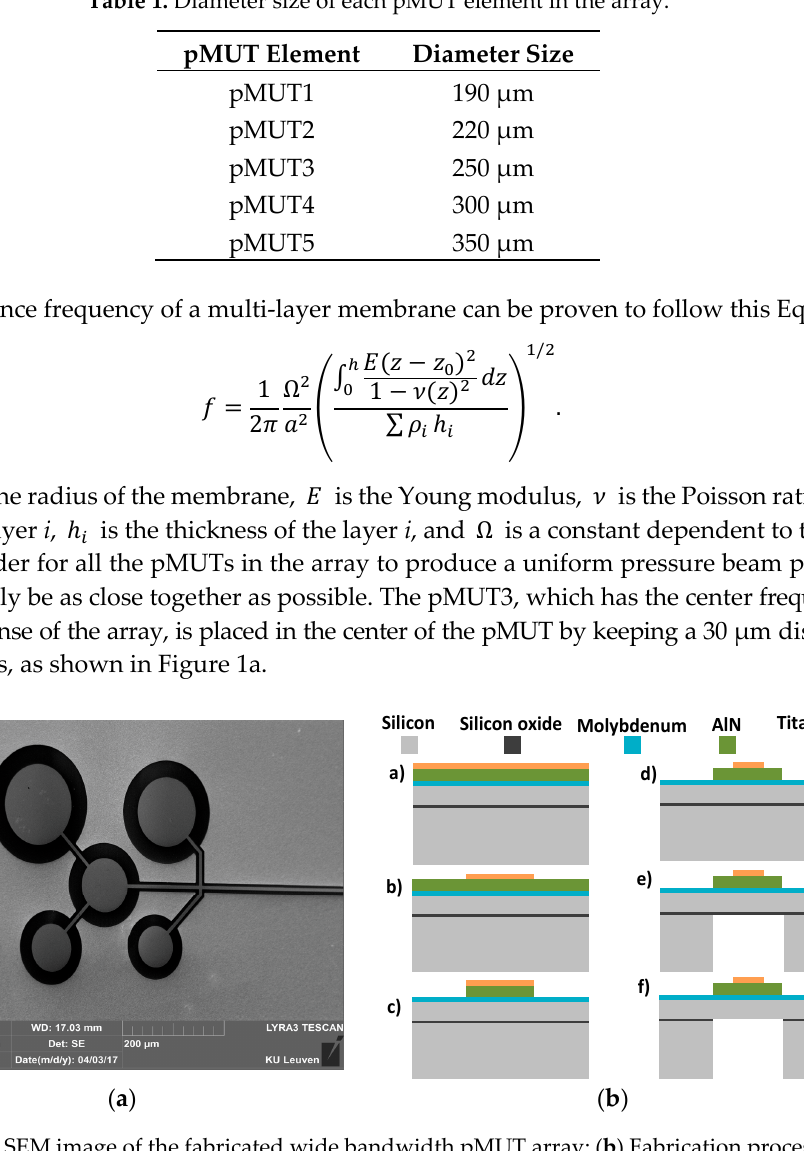
Figure 1. ( a ) SEM image of the fabricated wide bandwidth pMUT array; ( b ) Fabrication process flow: ( b - a ) sputtering of Mo/AlN/Ti stack; ( b-b ) patterning Ti to be used as the hard mask for AlN; ( b-c ) patterning AlN; ( b-d ) patterning Ti as top electrode; ( b-e ) backside DRIE; ( b-f ) Buried oxide wet